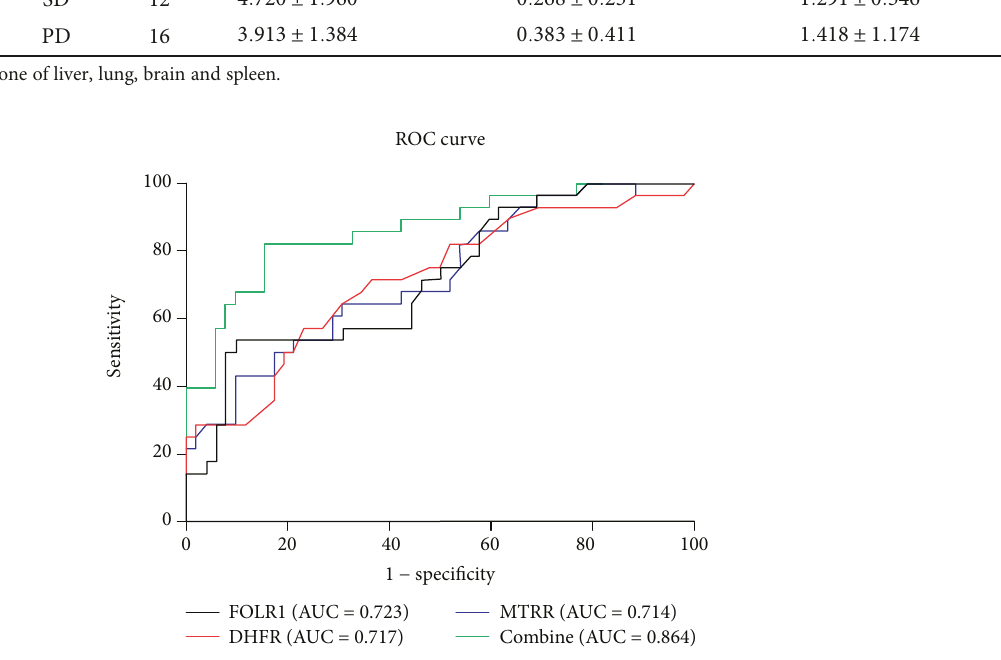
Figure 3: ROC curves for FOLR, DHFR, and MTRR and the combination of the three enzymes in predicting platinum